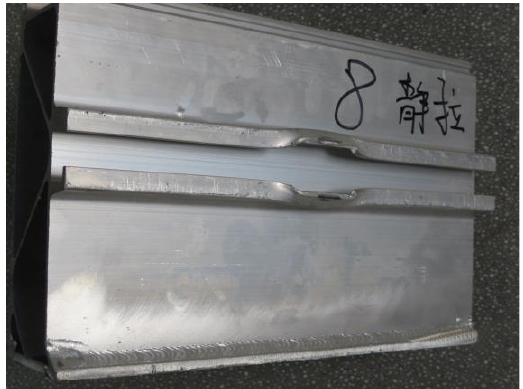
9 of 14 Figure 9. Test structure component being clamped on the tester.